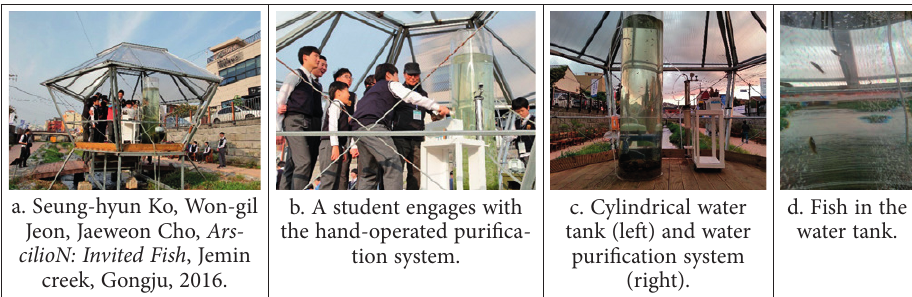
a. Seung-hyun Ko, Won-gil Jeon, Jaeweon Cho, Ars- cilioN: Invited Fish , Jemin creek, Gongju,